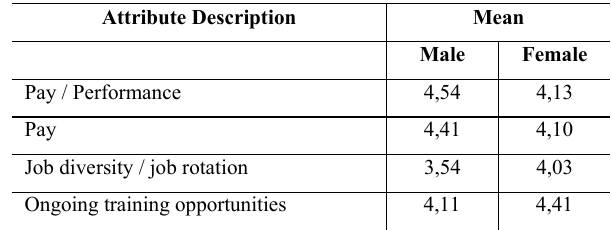
Table 7: The significant differences between the